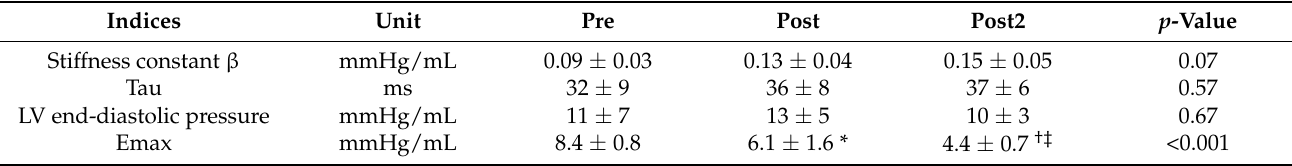
Table 1. Pressure-volume analysis measurement by invasive catheterization in dog model of DXR-ICM.